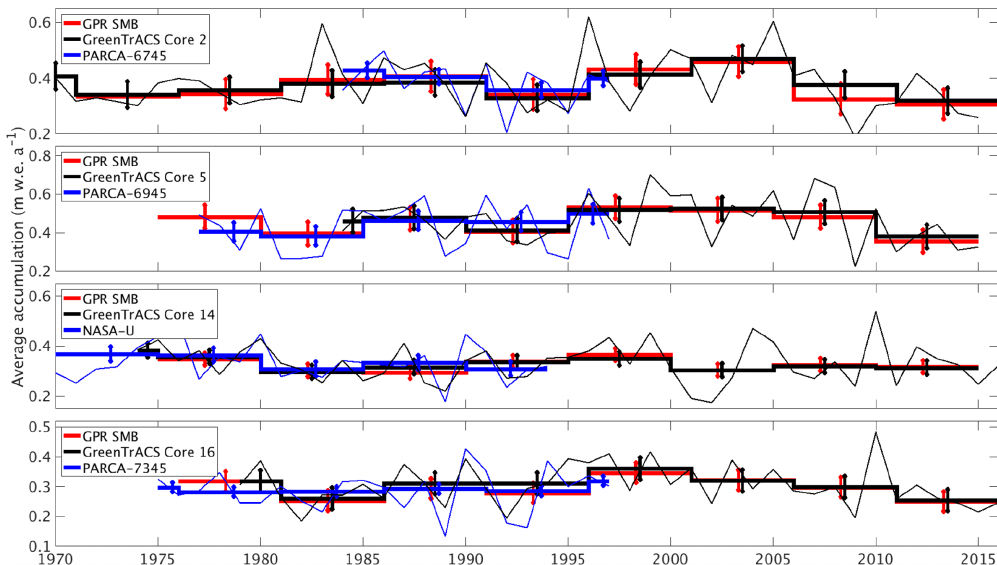
Figure 5. Accumulation rates from GPR and collected firn cores (this study) compared with cores from the PARCA Campaign. Thin lines represent annual PARCA (blue) and GreenTrACS (black) firn core accumulation rates, while thick lines are 5-year averages over correspond- ing GPR epochs. Error bars represent one standard deviation over each epoch. GPR and PARCA accumulation rate averages and decadal trends are statistically